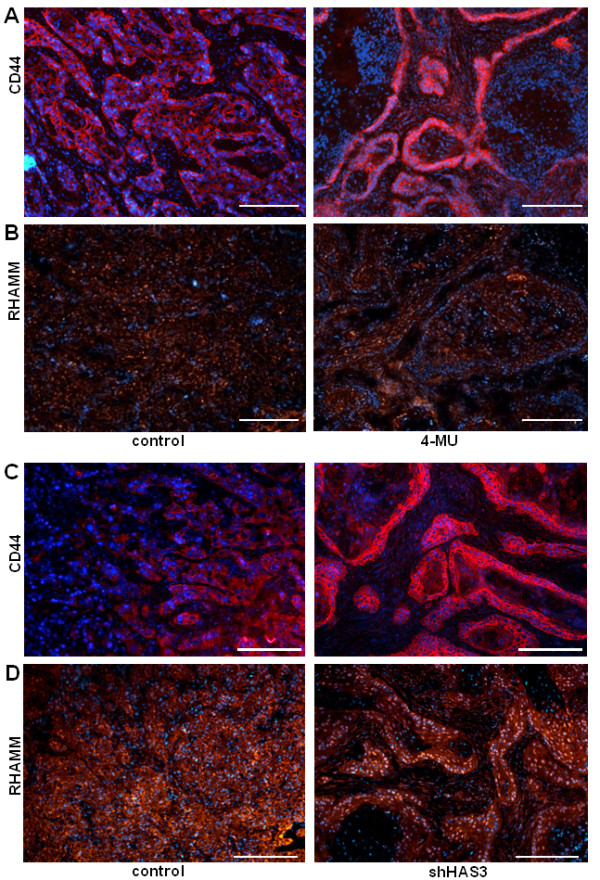
Expression of CD44 and RHAMM in response to 4-MU versus shHAS3. (A) 4-MU, immunostaining of human CD44 (red) revealed that CD44 was redistributed to the interface between tumour cells and stroma in response to 4-MU. (B) 4-MU, RHAMM was detected in both OSC1 cells and stromal cells. (C) shHAS3, shHAS3 transduction of tumour cells caused a similar redistribution of human CD44 (red) to the tumour-stroma interface. (D) shHAS3, RHAMM (red) was detected in both shHAS3 transduced OSC1 and stromal cells. Scale bars, 200 μm. Shown are representative images of n = 6 (control) and n = 7 (shHAS3) experiments.